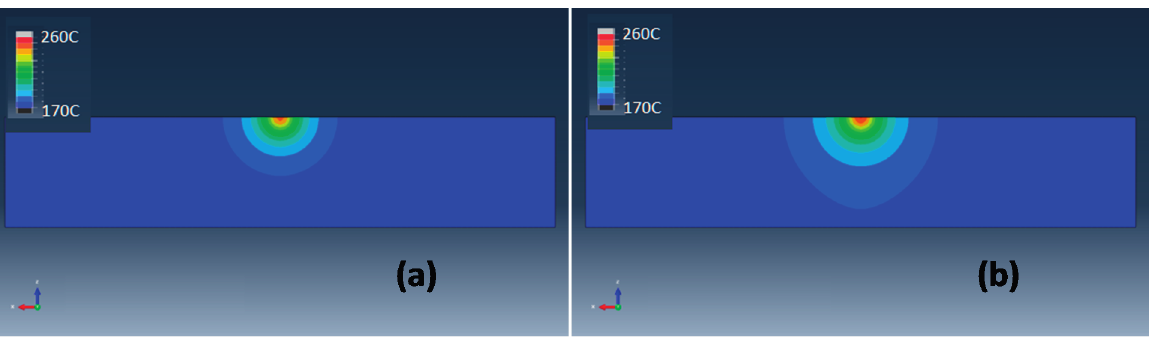
Figure 4. Melting depth modeling of laser sintering of ( a ) PA12 and ( b ) PA12-CNT.